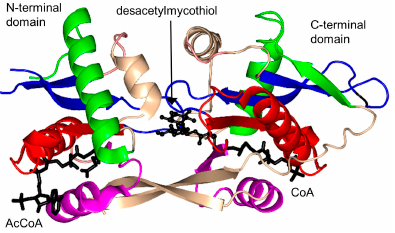
Figure 19. Cartoon representation of the structure of M. tuberculosis MshD in complex with desacetylmycothiol, AcCoA and CoA (PDB ID: 2C27 [187]). The conserved and non-conserved motifs of the GNAT domain, cofactor and substrate are colored as in Figure 3.